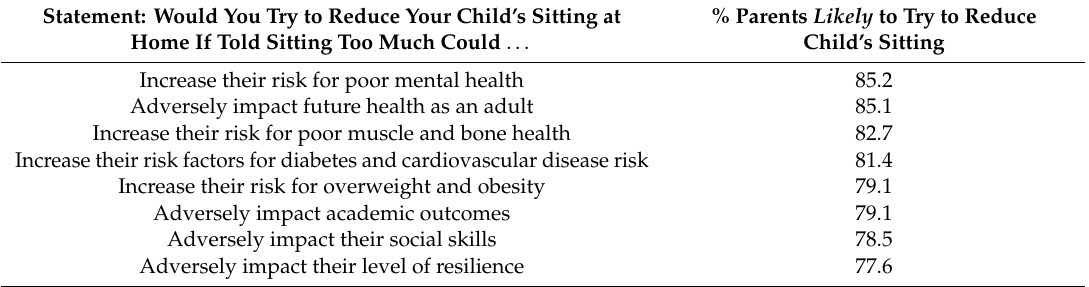
Table 3. Percentage of parents who would try to reduce their child’s sitting based on health risk